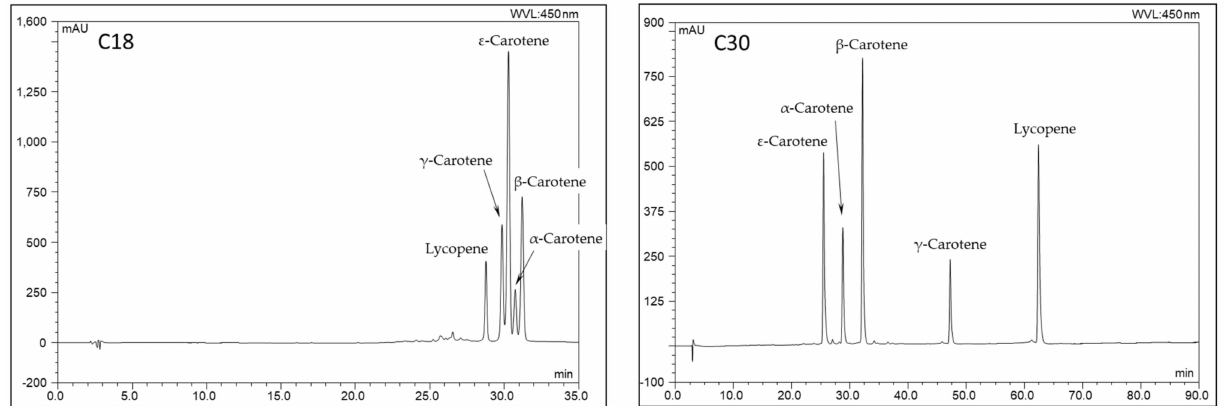
Figure 4. Separation of carotene mixtures for C 18 and C 30 reversed-phase columns. C 18 Conditions: Technokroma C18 5 µ m stat. phase (250 × 4.6 mm), 22 ◦ C. Eluents: A: MeOH/H 2 O = 12/88 v / v %,